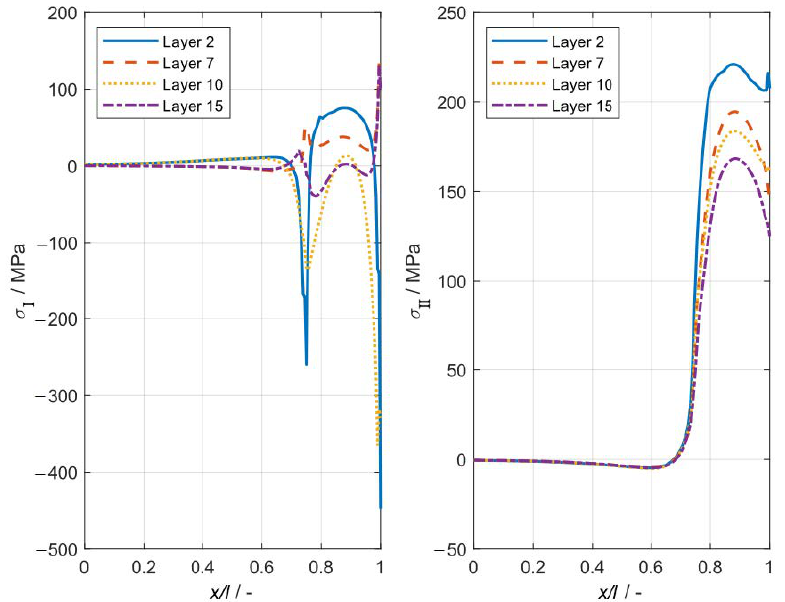
Figure 6. Longitudinal and transverse residual stresses along the x-direction in 0° layers at the specimen center y = 0.5 w .